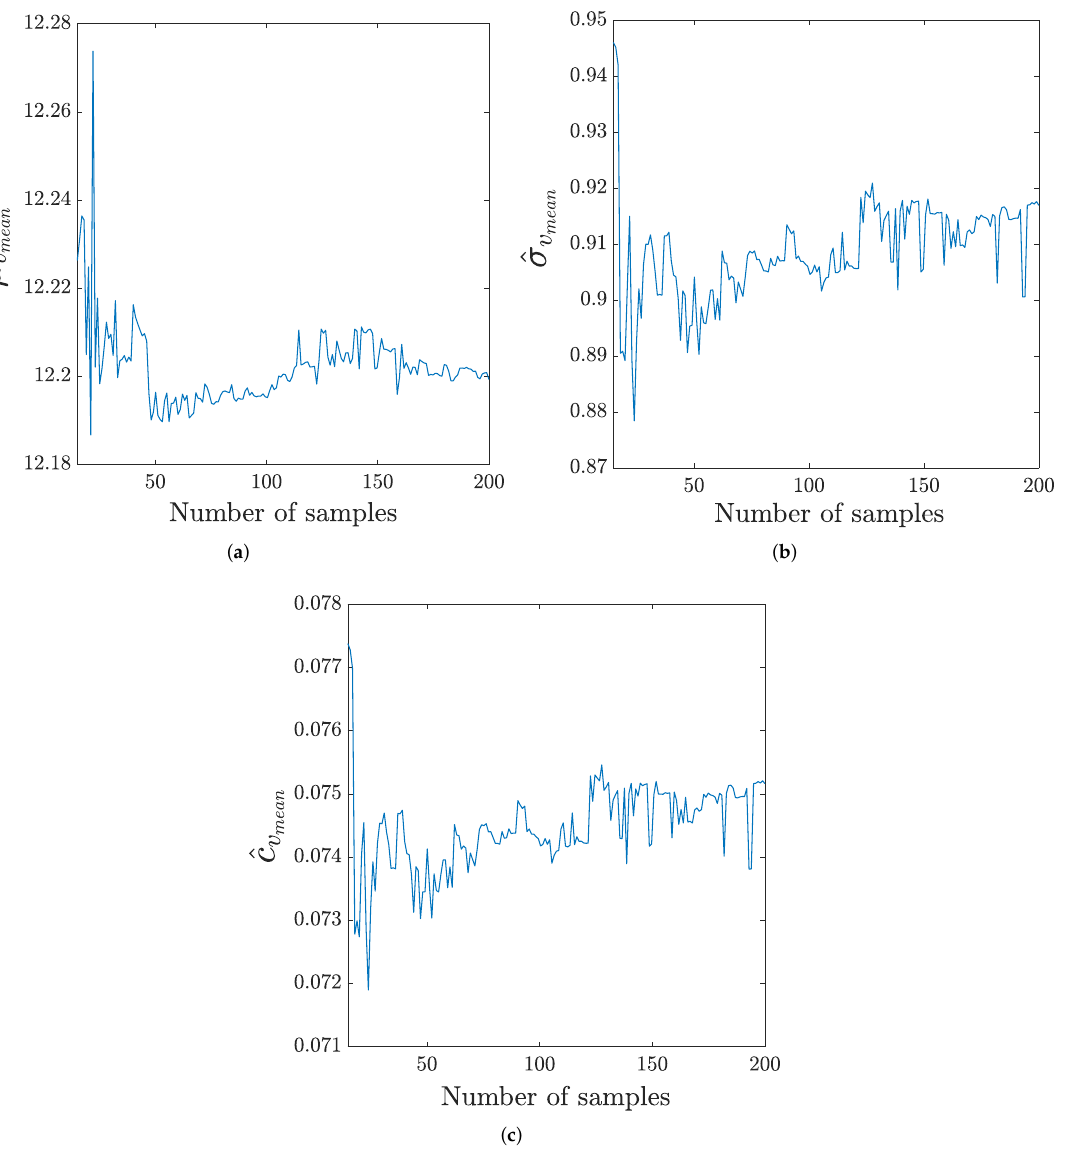
Figure 9. Convergence of PCE-based moments estimates of ( a ) mean, ( b ) standard deviation and ( c ) CV of QoI v mean